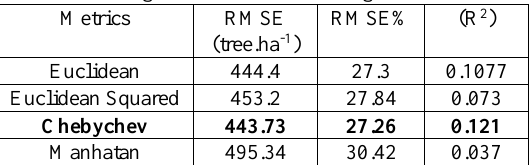
Table 2. The results of k-NN algorithm with different height metrics for estimating TD